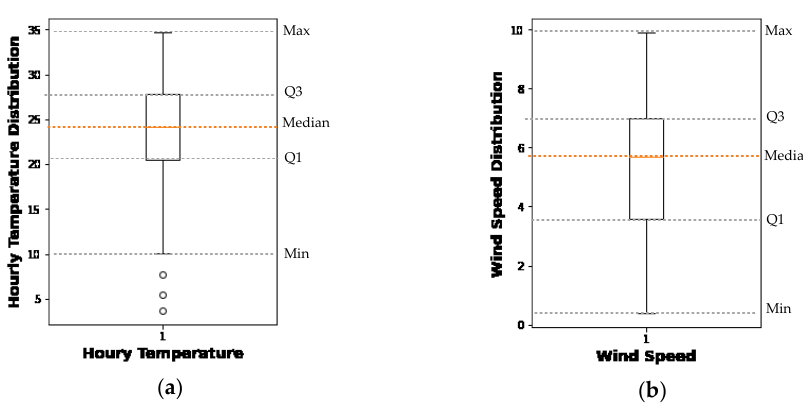
Figure 6. Box plot: ( a ) hourly temperature distribution ( b ) wind speed distribution.